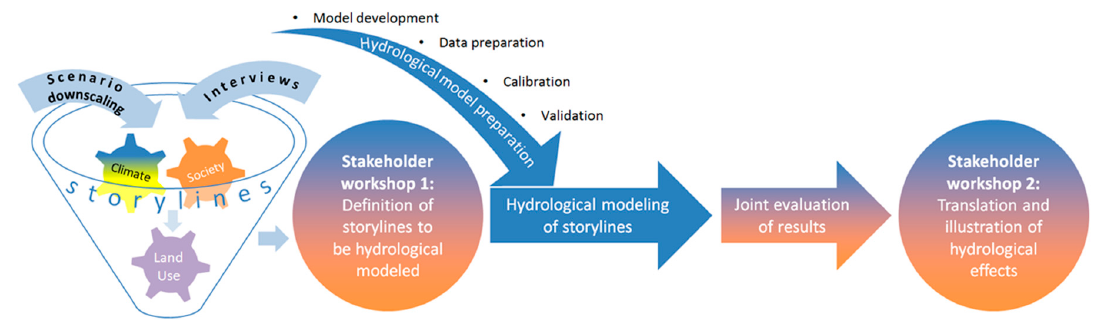
Figure 2. Flow chart indicating the methodological steps of the STorylines of coupled socio-Economic and cLimatic drivers for Land use and their hydrological impacts in Alpine catchments (STELLA) (blue denotes the role of science and brown symbolizes the contribution of non-scientific stakeholders).